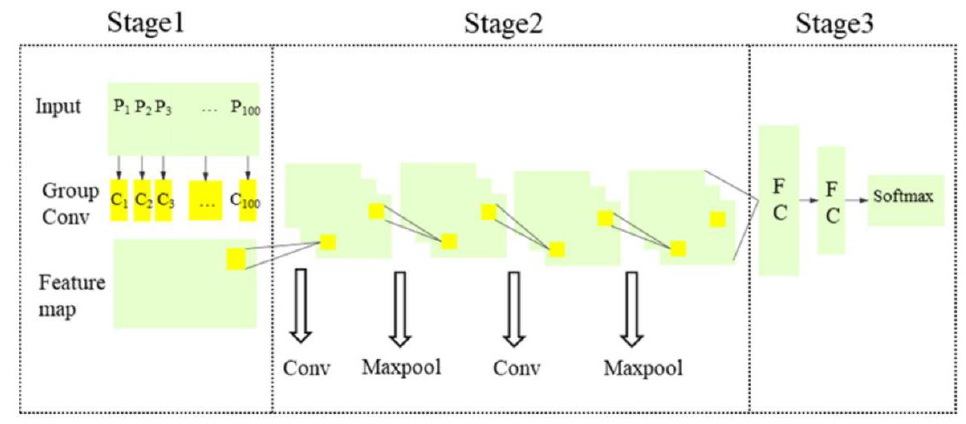
Figure 20. 100 G-Net structure diagram [75].